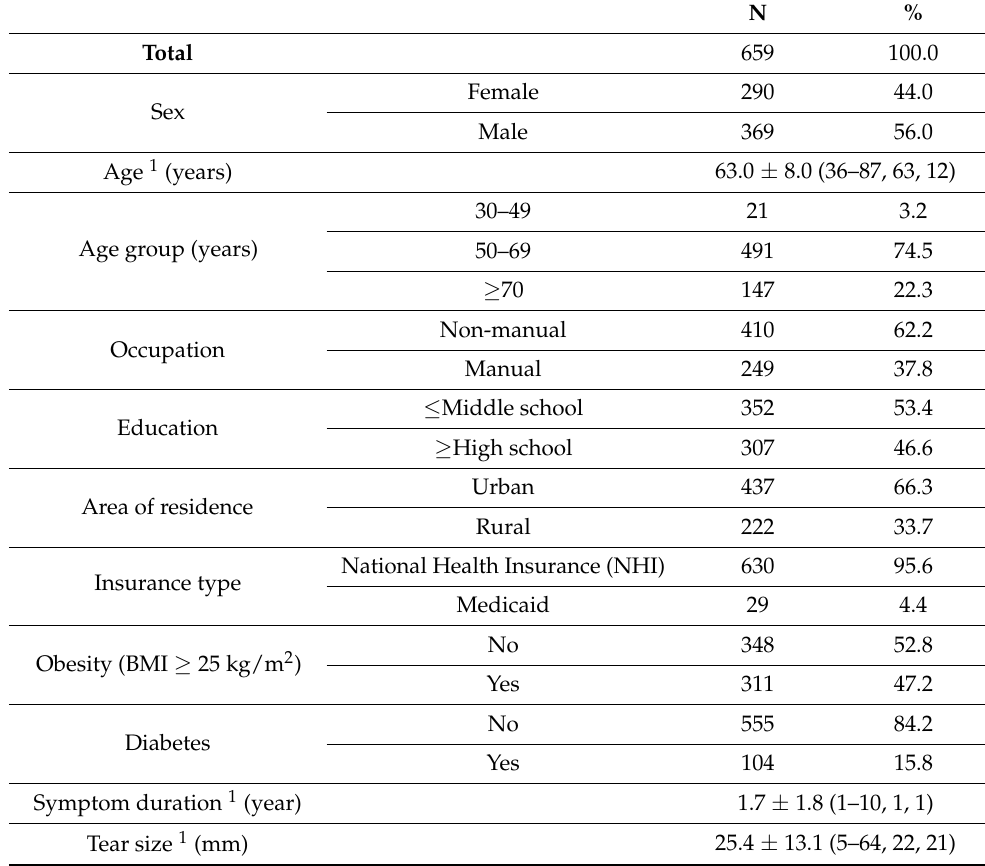
Table 1. General characteristics of the